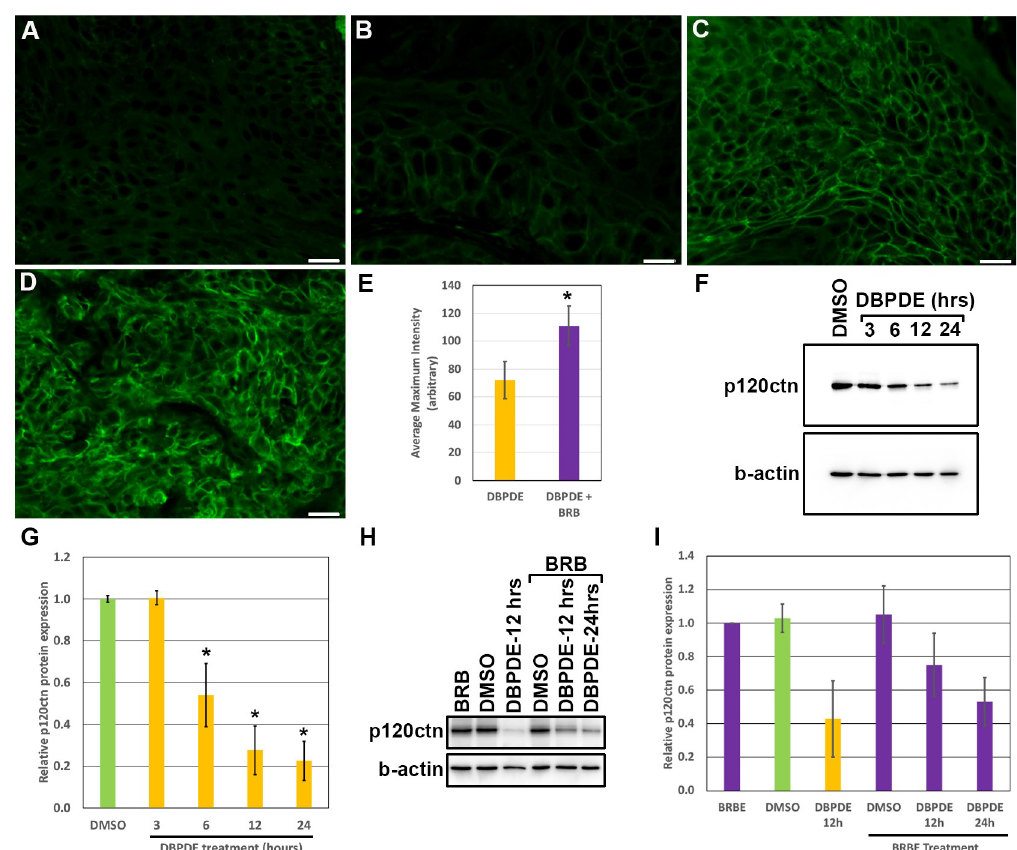
Fig 5. p120ctn expression increases in BRB treated mice. IF for p120ctn was performed on oral mucosal tissue samples harvested from C57Bl/6 mice treated with DBPDE with BRB (n = 10) and without BRB (n = 7) administration. Mice treated with DBPDE alone, panels (A) and (B), have a relatively low expression level of p120ctn while DBPDE + BRB treated mice have relatively increased levels of p120ctn, panels (C) and (D). Panels (A) and (C) represent papillomas while panels (B) and (D) represent invasive cancer. Scale bar = 20uM. (E) Quantification of the mean intensity of p120ctn IF from representative images of papillomas and invasive cancers from all DBPDE treated mice, with and without BRB. (F) Western blot analysis for p120ctn protein levels in DBPDE treated NOK-hTERT cells. b-actin serves as a loading control (G) Quantification of the p120ctn band intensities from western blot analysis, normalized to b-actin (n = 3). (H) Western blot analysis for p120ctn protein levels in DBPDE and/or BRBE treated NOK-hTERT cells. b-actin serves as a loading control (I) Quantification of the p120ctn band intensities from western blot analysis, normalized to b-actin (n =